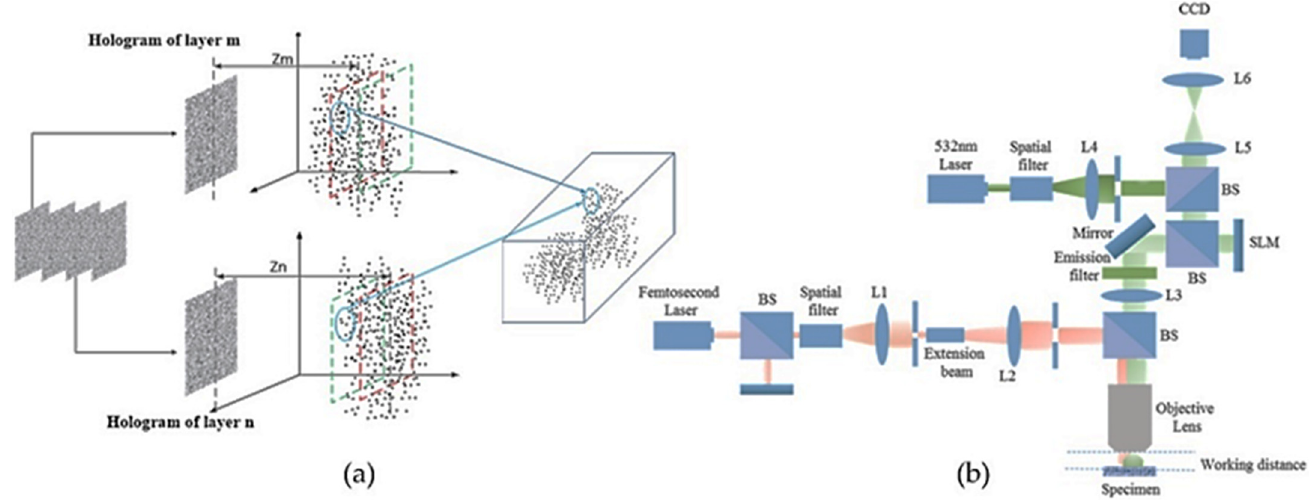
Figure 20. ( a ) Overlapping object points after reconstruction of each layer in the hologram, and ( b ) the optical setup for the proposed system (adapted from [39]).